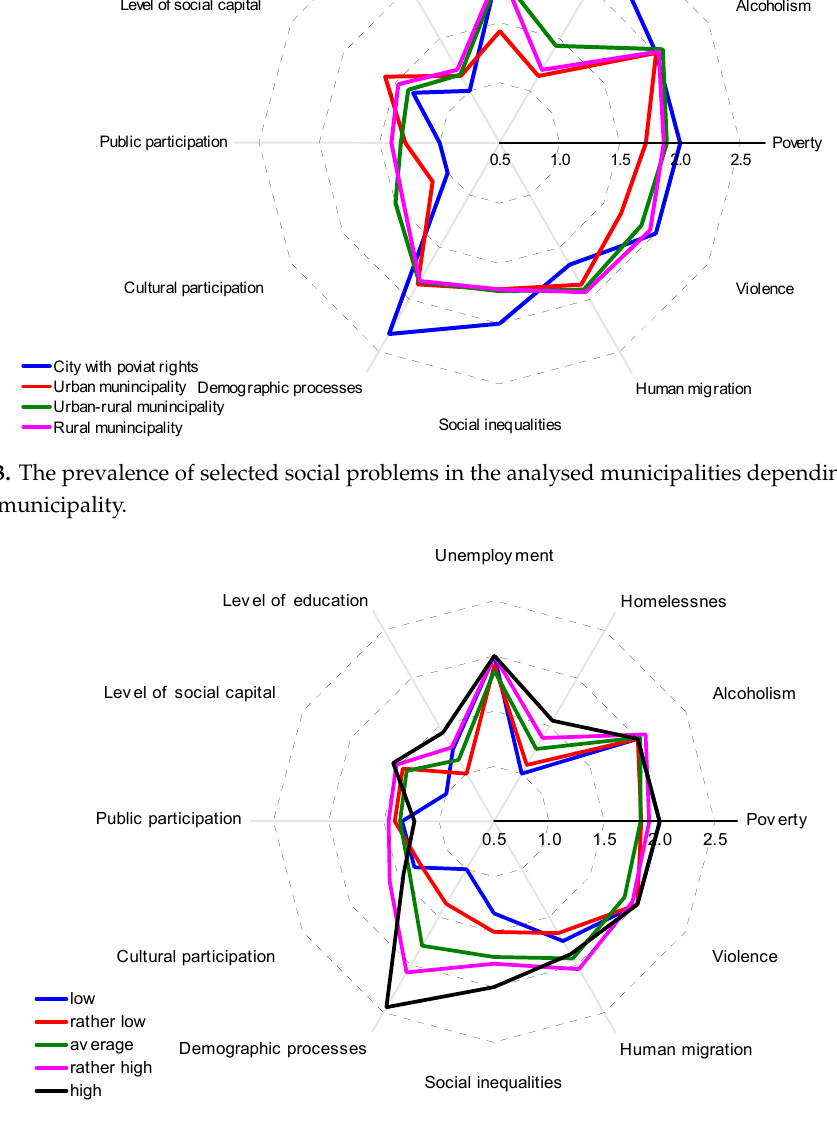
Figure 3. The prevalence of selected social problems in the analysed municipalities depending on the type of municipality.